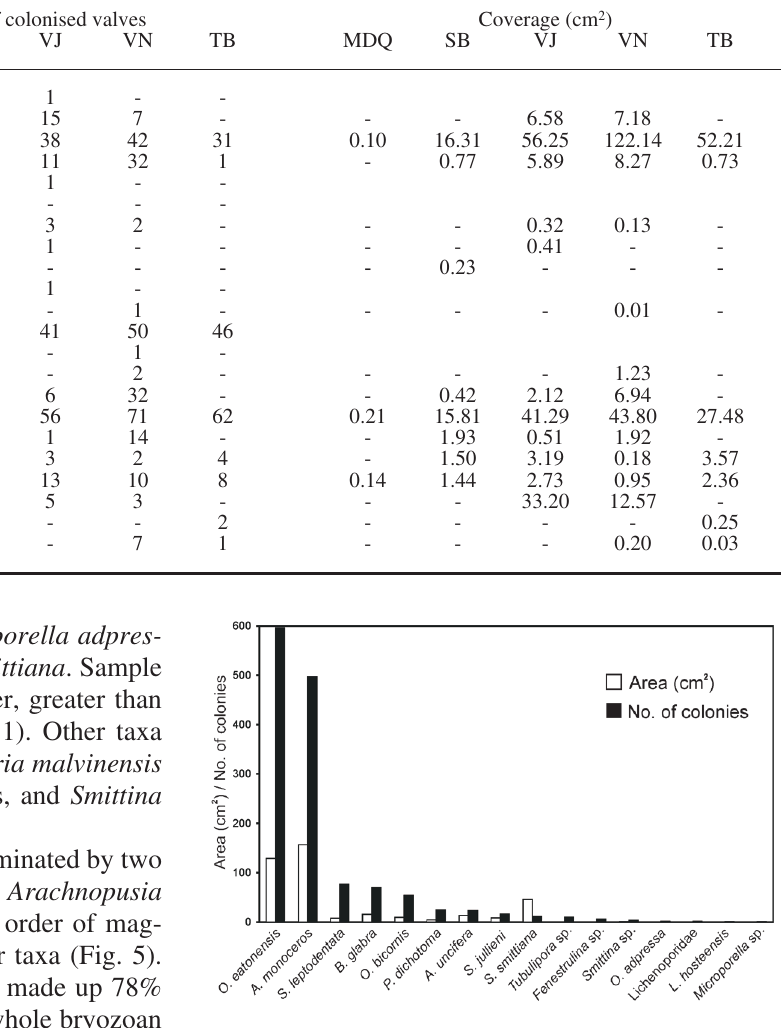
Fig. 5. – Coverage and abundance of each bryozoan species in all